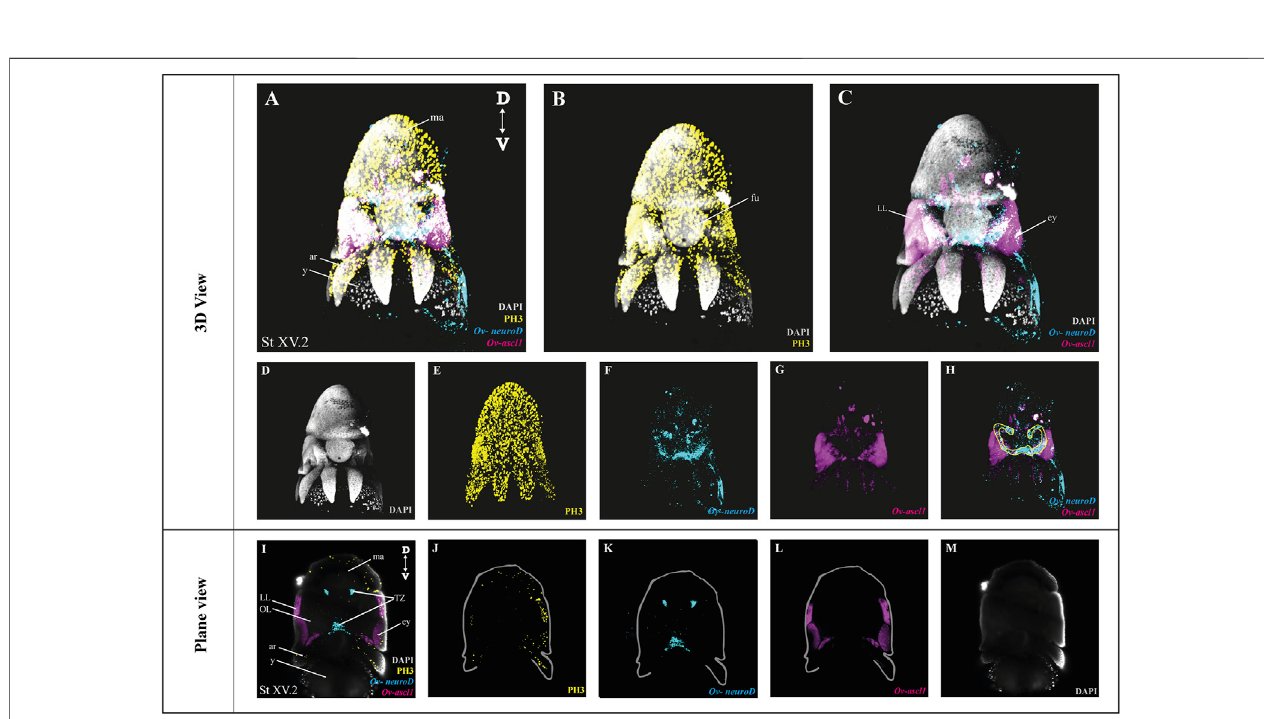
FIGURE 4 | Whole Mount multiplexed HCR v3.0-IHC followed by fructose-glycerol clearing on an Octopus vulgaris embryo (developmental stage XV) imaged with LSFM to visualize neurogenesis. (A) Overview image showing the expression of Ov-ascl1 and Ov-neuroD and presence of mitotic cells (PH3+) on a Stage XV embryo in 3D view. DAPI(in grey) isused fornuclear labelling. (B) Image illustrating mitotic PH3+ cellswithDAPI which isanindicationofsuccessful IHC after HCR. (C) Multiplexed HCRImageof Ov-ascl1andOv-neuroD withDAPI. (D – G) Separatechannelsfrom (A) . (H) Overlayof Ov-ascl1andOv-neuroD showmutuallyexclusiveexpression. Yellow line indicates the transition zone area. (I) Overview image showing the expression of Ov-ascl1 and Ov-neuroD and presence of mitotic cells (PH3+) on a coronal section of Stage XV embryo. (J – M) 4 individual channels from (I) . Abbreviations: ar, arm; D, dorsal; ey, eye; fu, funnel; LL, lateral lip; ma, mantle; OL, optic lobe; SUB, subesophageal mass; V: ventral; y,